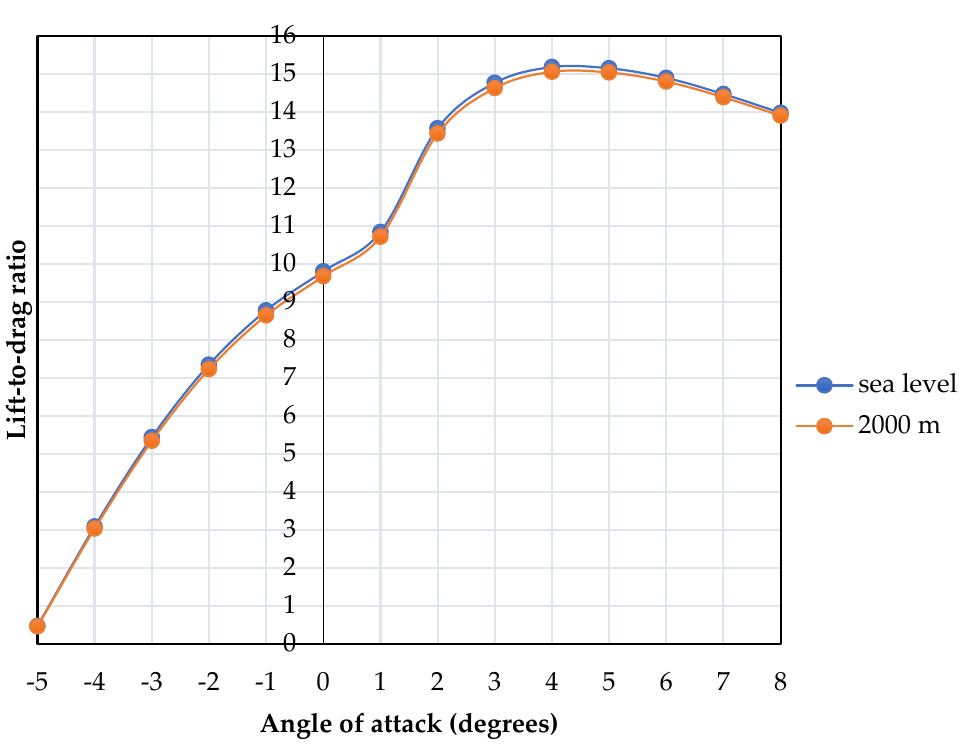
Figure 24. Lift-to-drag ratio versus angle of attack.